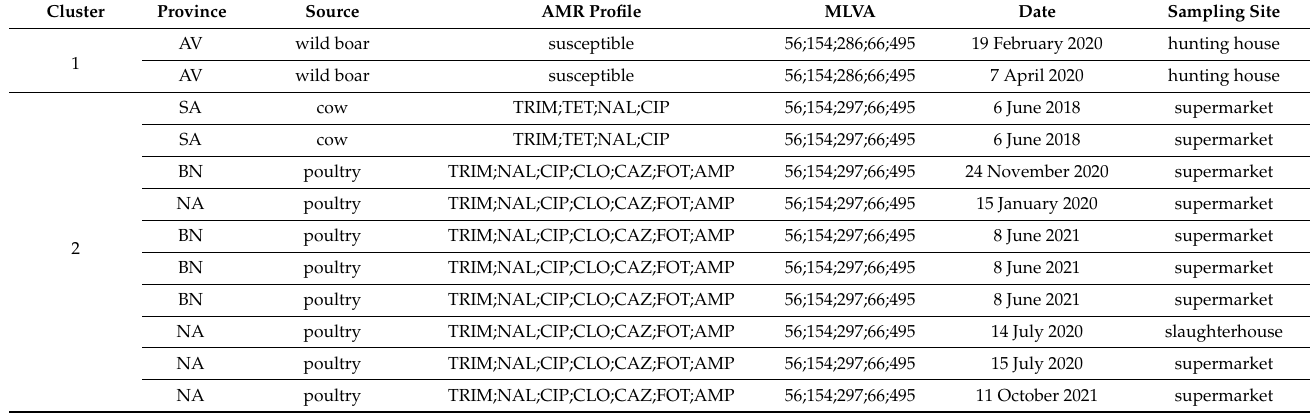
Table 4. Correlations between S. Infantis strains taking in consideration the cluster, geographical location (AV = Avellino; SA = Salerno; BN = Benevento; NA = Naples), source, antimicrobial resistance (AMR) profile, MLVA profile, date of sampling and sampling